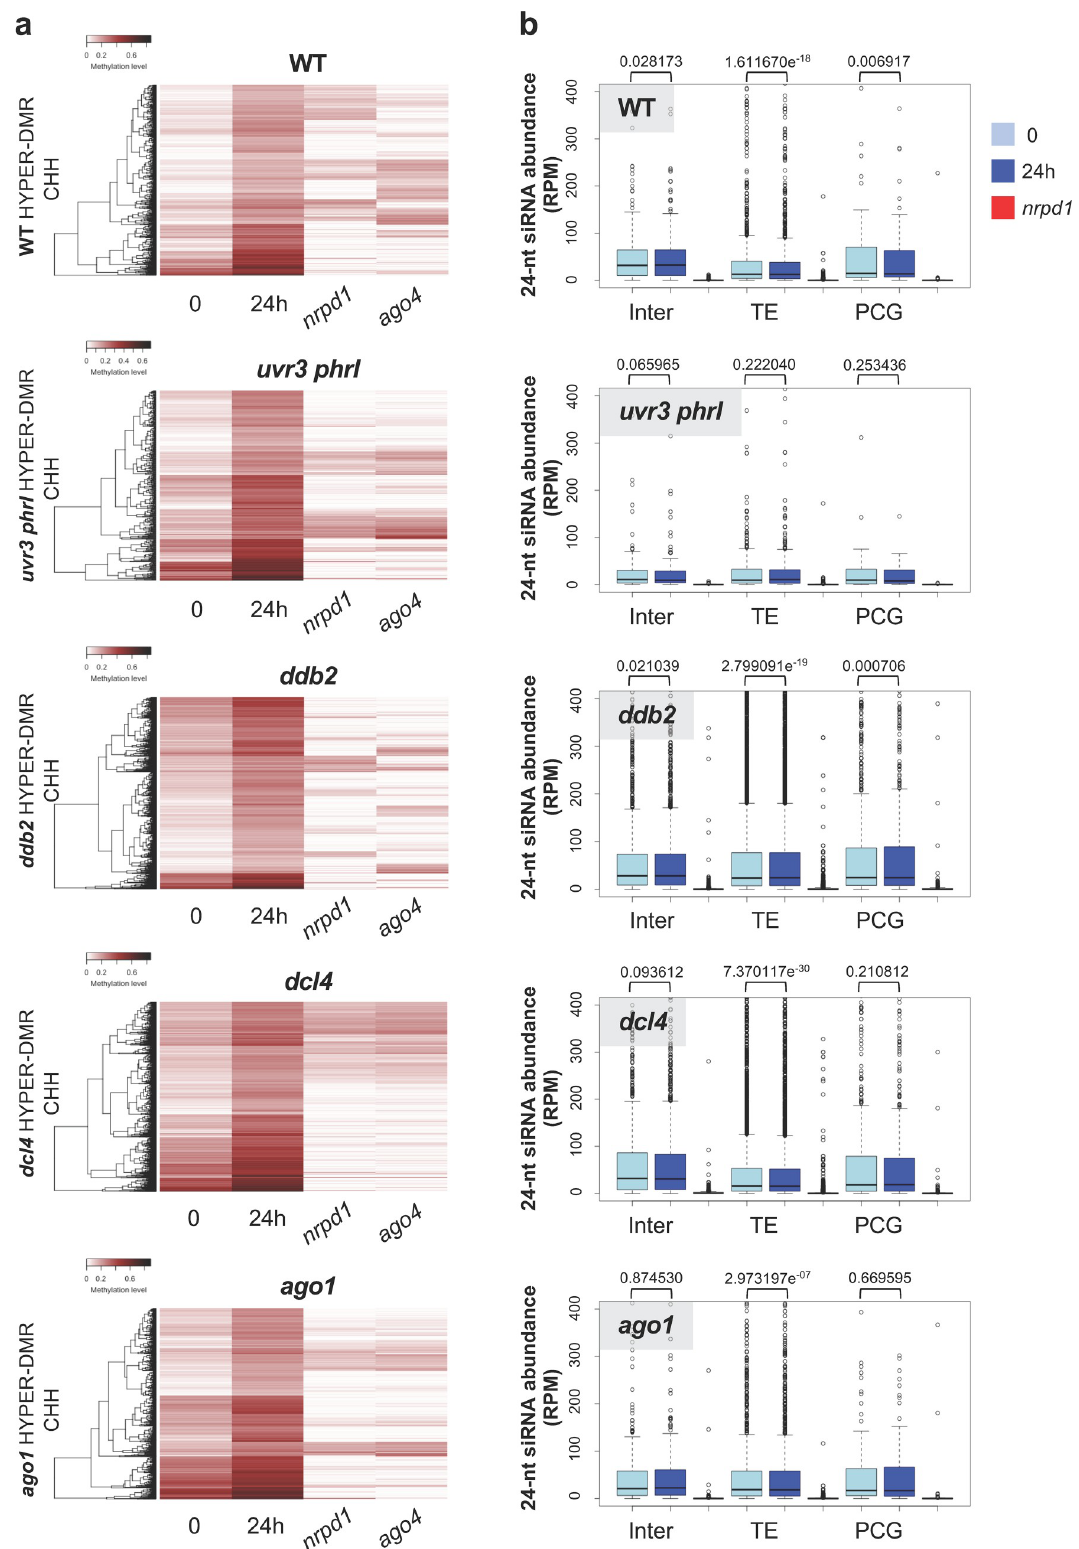
Fig 4. RNA-directed DNA methylation and DMRs. a Heatmaps of CHH methylation levels within hyper-DMRs identified in WT, uvr3 phrI , ddb2 , dcl4 and ago1 plants before, 24h upon UV-C exposure. The CHH methylation levels of each of these hyper-DMR are